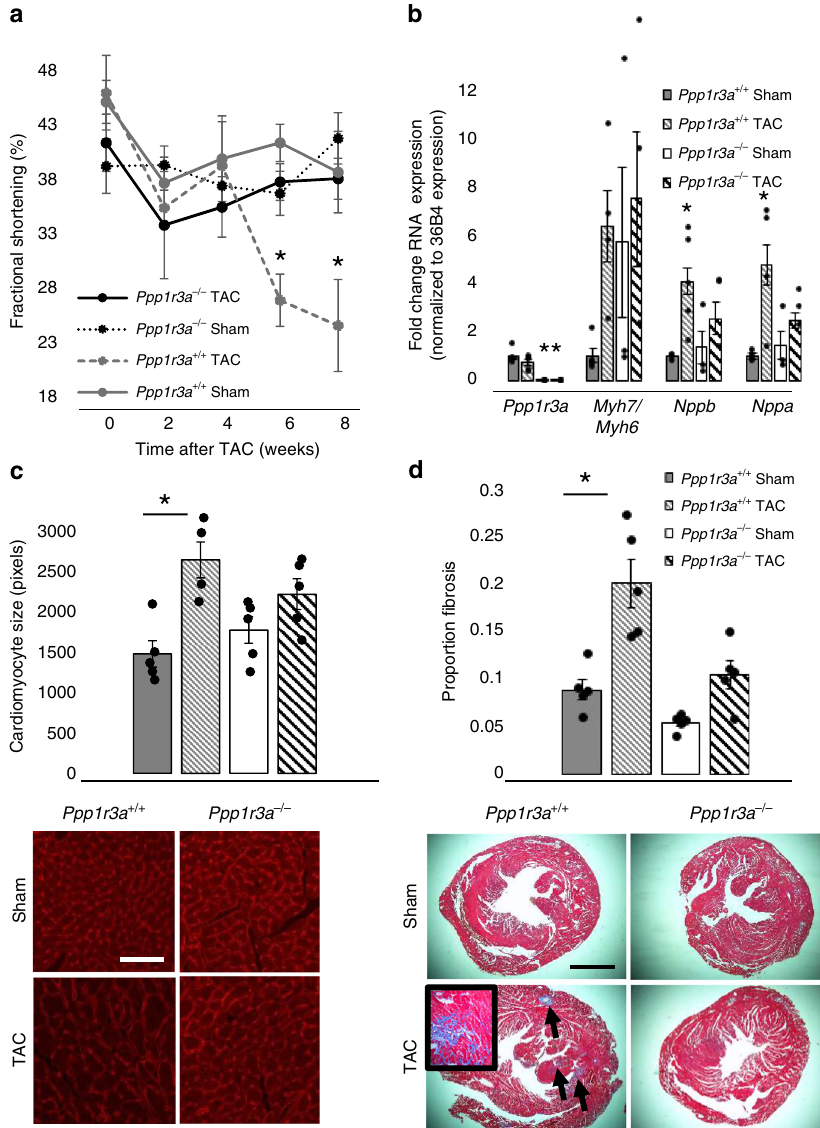
Fig. 5 Cardiac effects of PPP1R3A ablation in vivo. a Fractional shortening is preserved in Ppp1r3a − / − mice after TAC. At 6 weeks ( n = 5 animals for all groups), Ppp1r3a − / − TAC 37.6 ± 4.3%, Ppp1r3a − / − Sham 36.5 ± 4.7%, Ppp1r3a + / + TAC 26.7 ± 9.5%, Ppp1r3a + / + Sham 41.2 ± 8.4%, p = 0.03 ANOVA